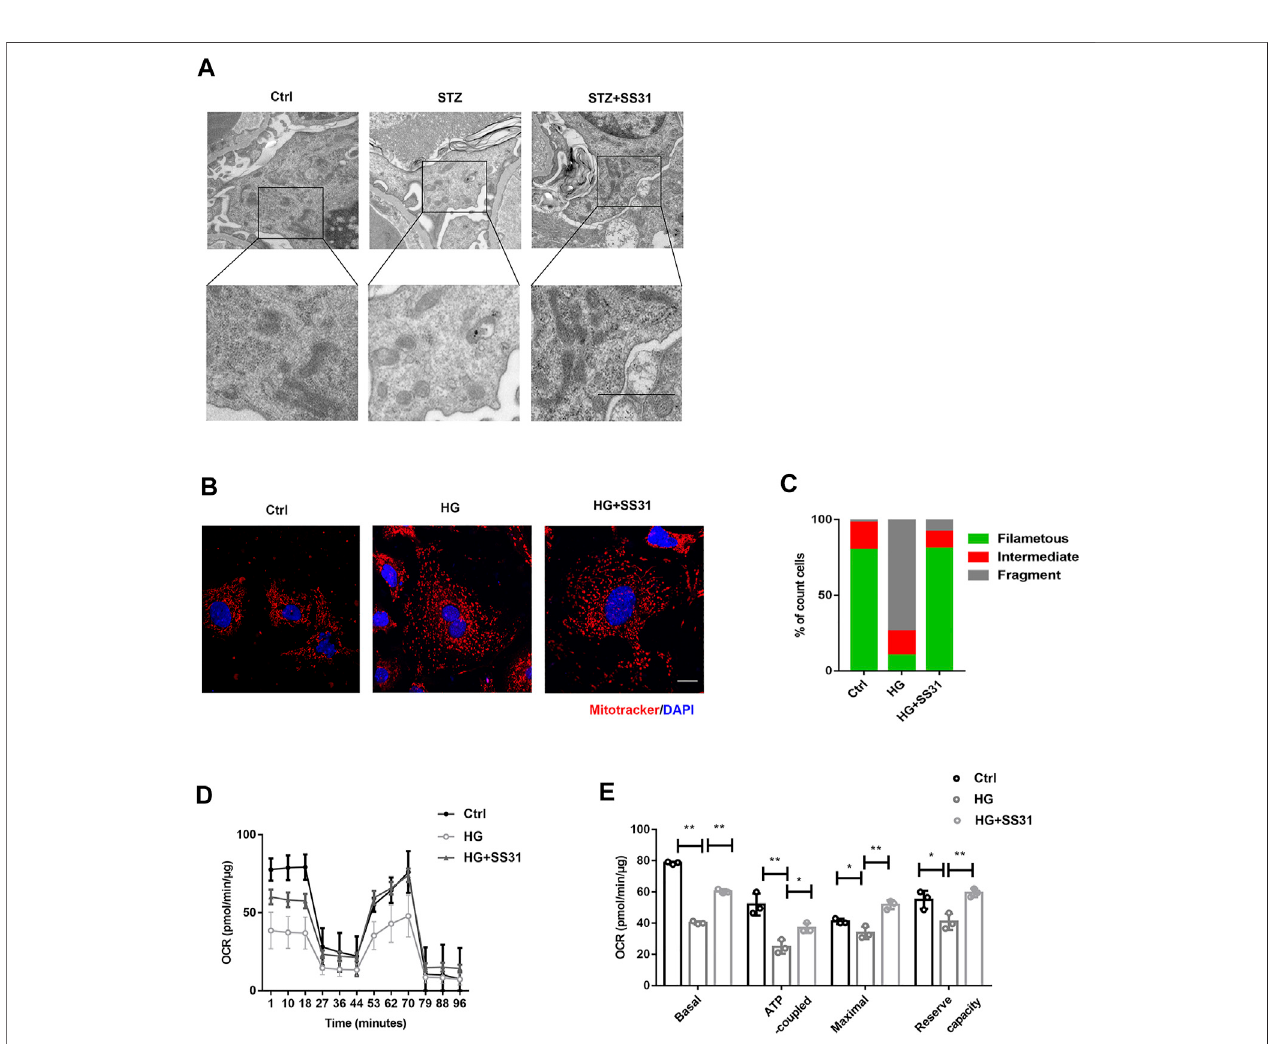
FIGURE 3 | SS31 inhibits HG-induced mitochondrial injury. (A) Mitochondrial morphology of podocytes from control and STZ treated mice in the presence or absence of SS31. As shown in the TEM images, SS31 preserved mitochondrial cristae sharp in podocytes from diabetic mice. (Bar (cid:1) 2.5 μ m). (B) Confocal images showing mitochondria labeled with MitoTracker Red (red) and DAPI (blue). SS31 markedly ameliorated mitochondrial fragmentation. (Bar (cid:1) 2.5 μ m) (C) The histogram showing the percentage of different mitochondrial morphologies in podocytes from the indicated groups. (50 fi elds were randomly selected for statistics). (D) Representative traces showing OCR in indicated podocytes. (E) Statistical analyses of baseline respiratory capacity, ATP-coupled respiratory capacity, maximum respiratory capacity, and reserve respiratory capacity. n (cid:1) 4. * p < 0.05, ** p < 0.01: for basal, p < 0.001(Ctrl vs HG), p (cid:1) 0.003(HG vs HG + SS31), for ATP coupled, p (cid:1) 0.0048(Ctrl vs HG), p (cid:1) 0.0172(HG vs HG + SS31), for maximal, p (cid:1) 0.044(Ctrl vs HG), p (cid:1) 0.0048(HG vs HG + SS31), for reserve capacity, p (cid:1) 0.03(Ctrl vs HG), p (cid:1) 0.003(HG vs HG + SS31).